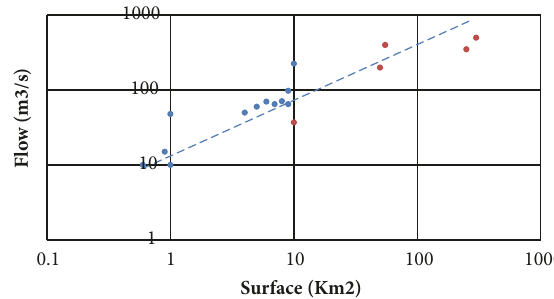
Figure 5: Probable flows based on catchment